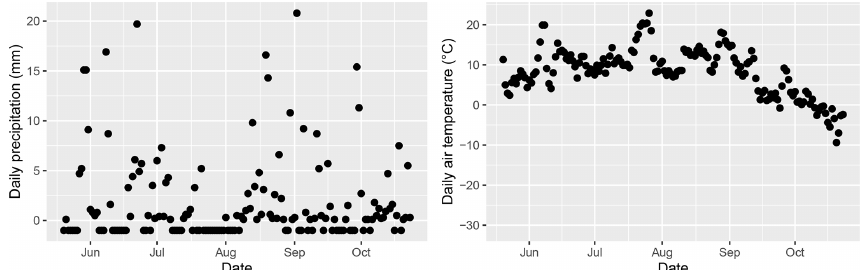
Figure A7. Daily precipitation and air temperature at Lompolojänkkä during summer 2019. Data originated from the nearest weather stations: Lompolonvuoma (for temperature) and Kenttärova (for